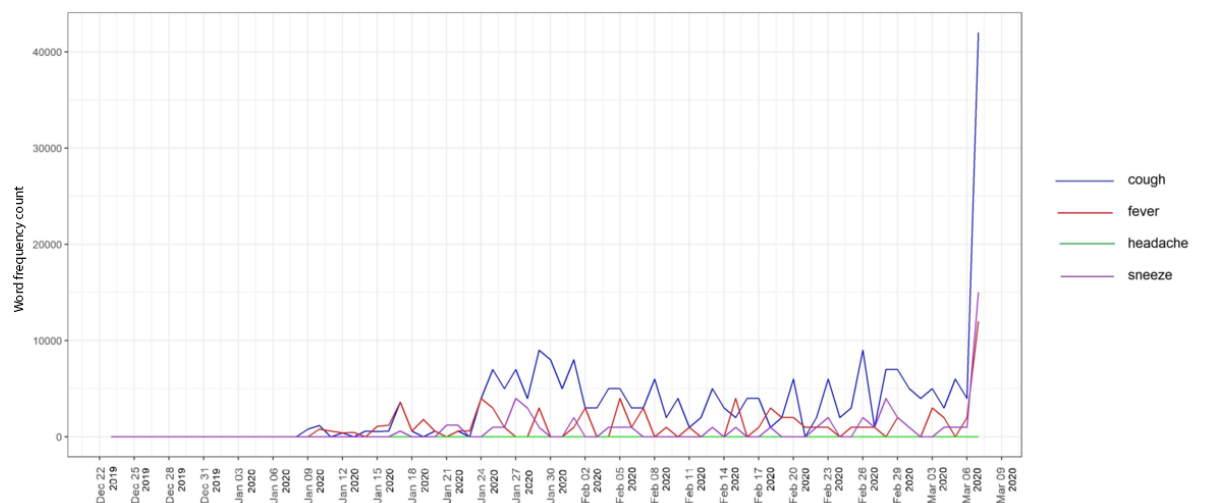
Figure 3. Trend lines indicating the word frequencies of four key COVID-19 symptoms on